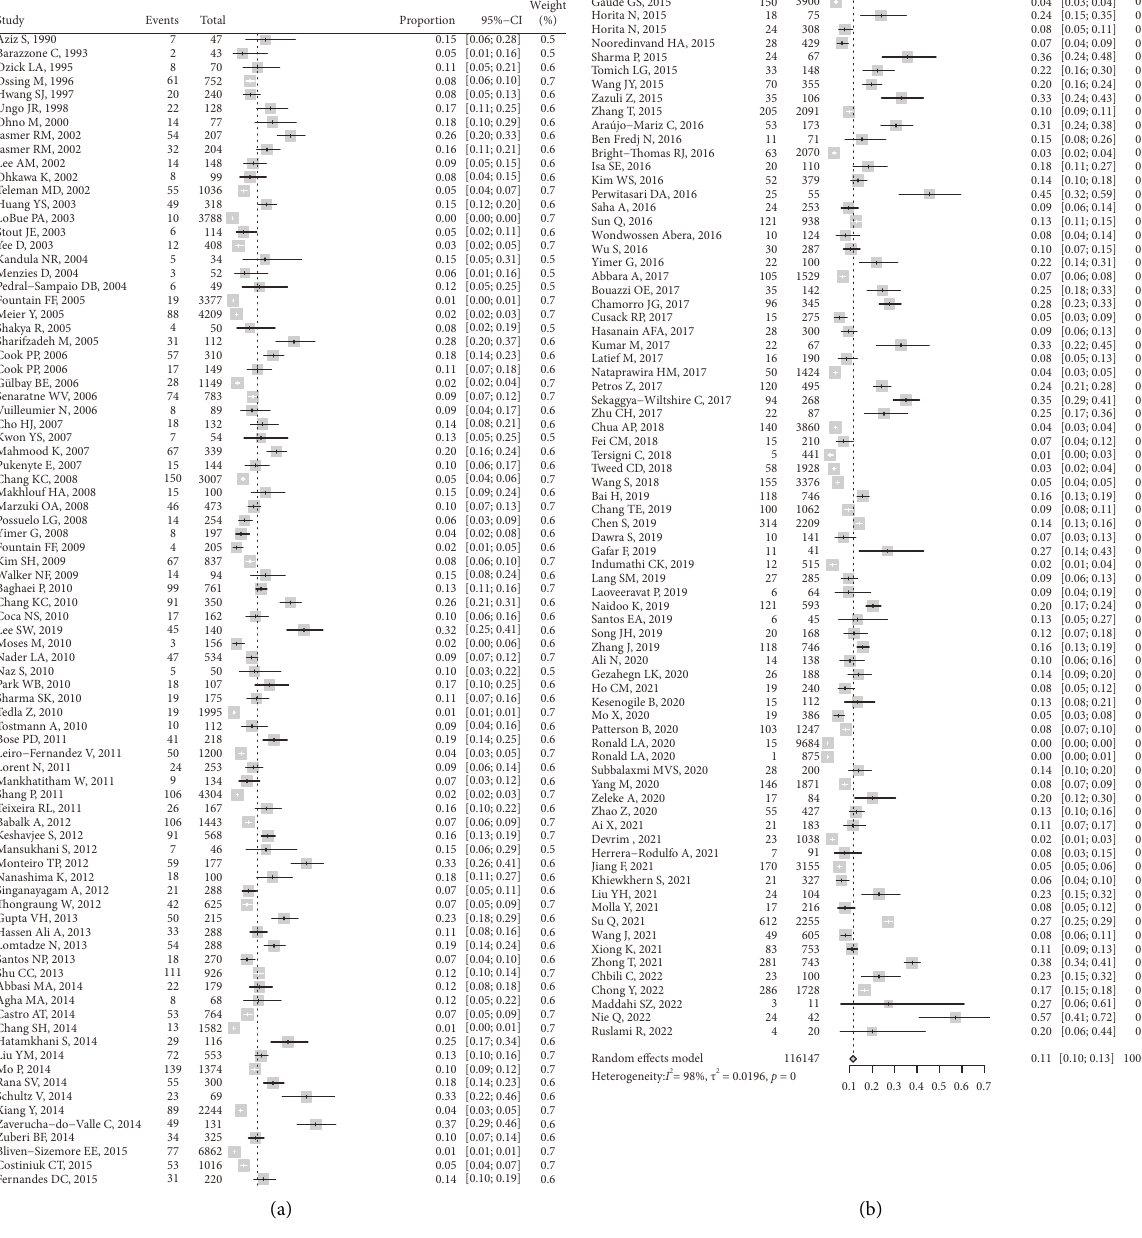
Figure 3: Forrest plot of pooled cumulative incidence of ATLI (random effects model) (ATLI, antituberculosis drug-induced liver